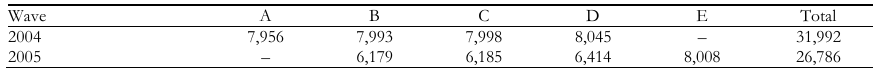
EU-SILC sampling design: composition of longitudinal replications in terms of Secondary Sampling Units (SSUs) waves 2004 and